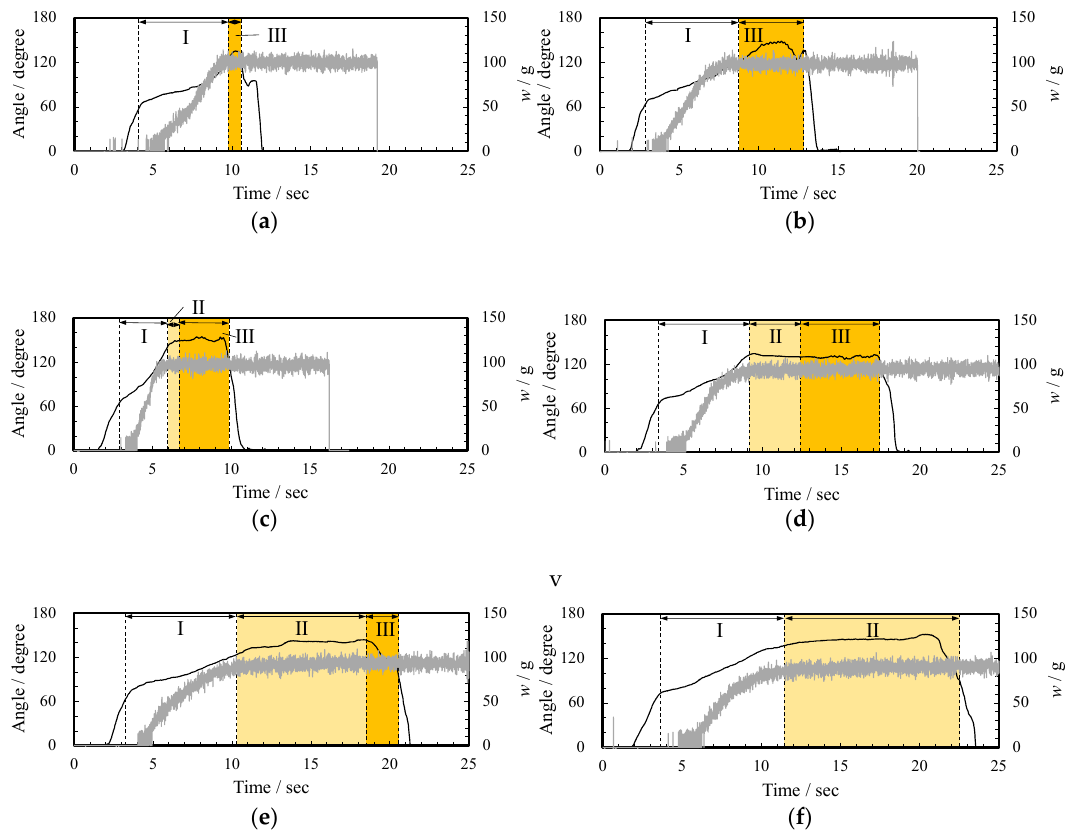
Figure 5. Relationship between angle (black line), weigh change (gray line), ( a ) pouring state when a subject (ID14) poured water ( a ); ( b )–( f ) pouring state when a subject (ID14) poured 1–5 wt% thickened aqueous solutions ( b – f ), respectively: (I) The flowing state, (II) yarning state, and (III) dripping state. Technologies 2020 , x , y FOR PEER REVIEW